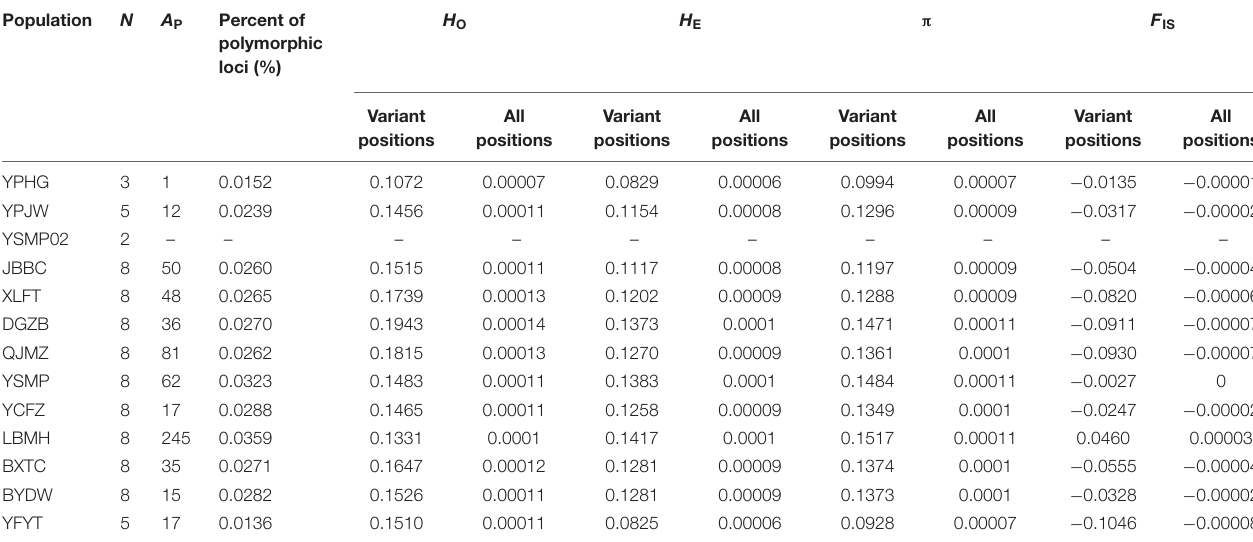
TABLE 1 | The statistical values of genetic diversity within populations from variant and all positions data of RAD-seq.